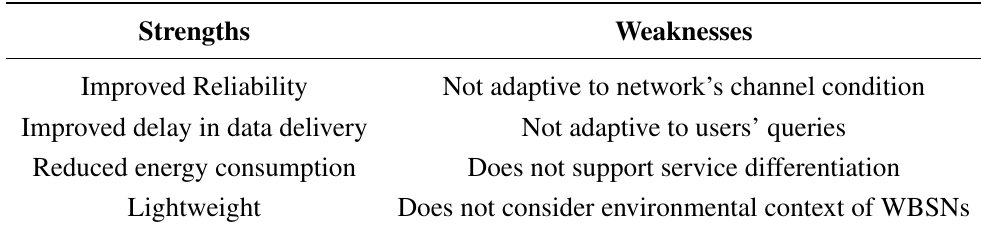
Table 5. The MP mechanism’s performance